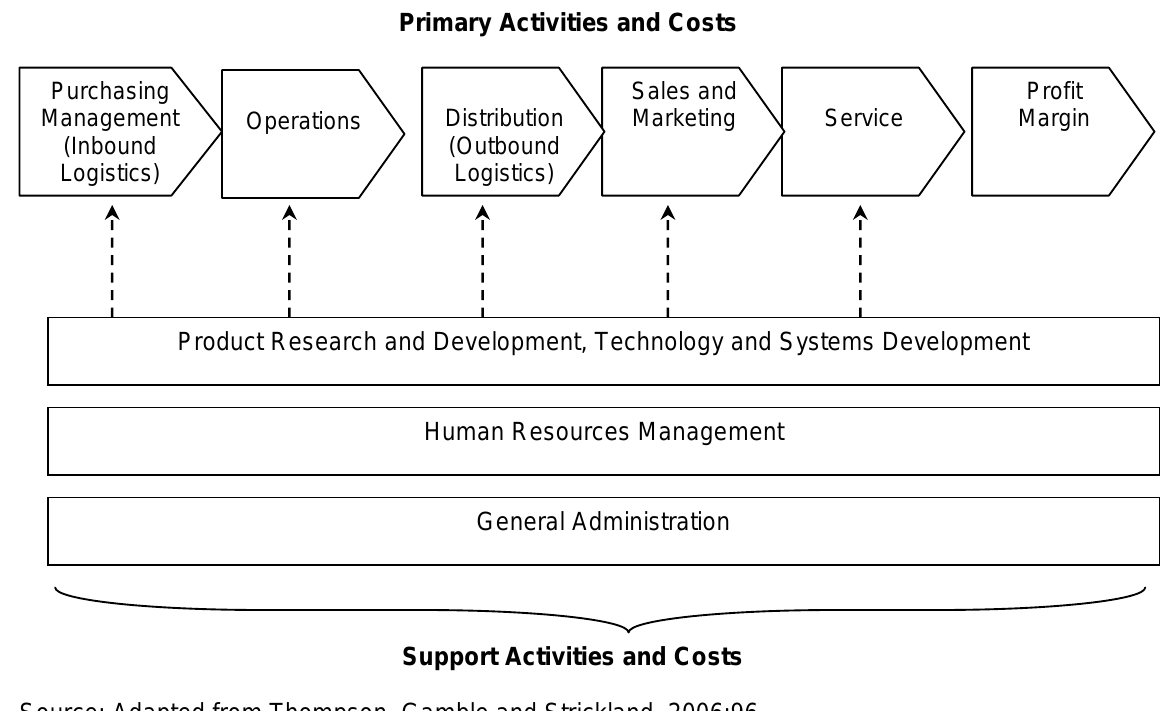
Figure 1: Porter’s Value